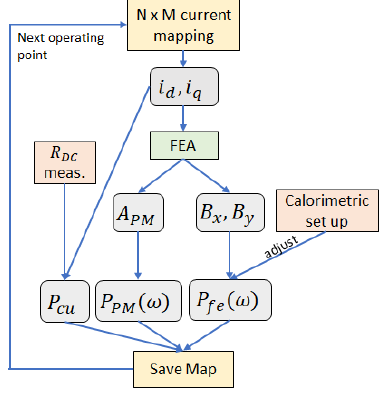
Figure 7. Loss mapping procedure flow